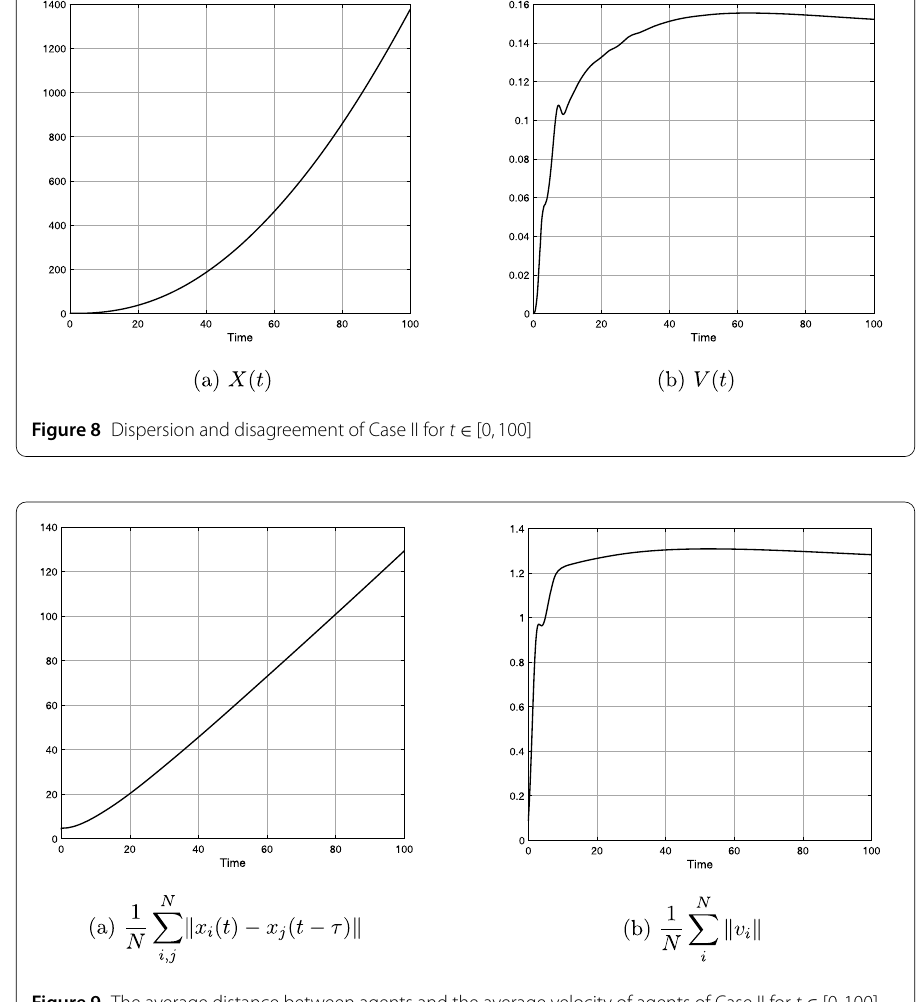
Case IV : C a < C r and l a > l r (see Figs.